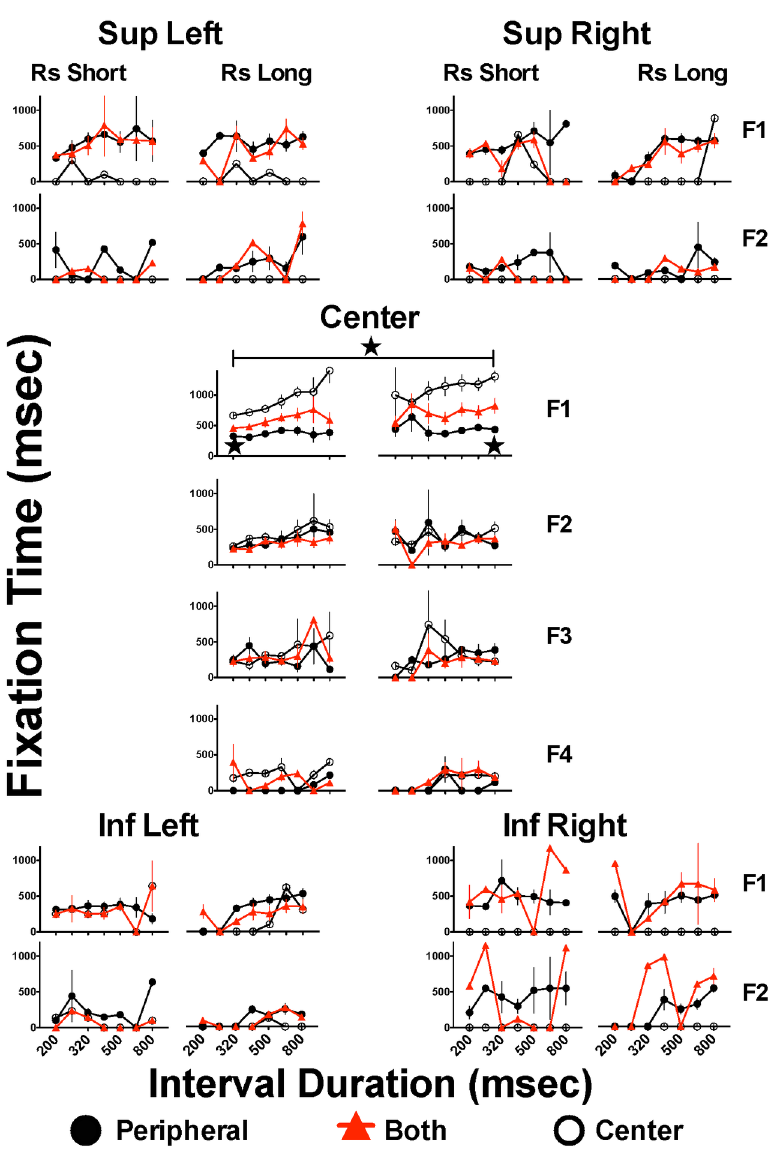
Fig 3. Duration of successive fixations on each Area of Interest during generalization trials. Mean fixation time in each successive fixation to each Area of Interest (AoI) where a stimulus could appear: fixation 1 (F1) to fixation 4 (F4) for Centre AoI but only F1 and F2 for remaining AoIs. For each fixation to each AoI, left panels present the performance on trials where subjects categorized intervals as “ short ” and right panels correspond to categorizations as “ long ” ; only intervals close to or at the extreme durations present mean of 15 subjects since some subjects never emitted erroneous categorizations. Stars and horizontal bars indicate significant differences between denoted groups after two-way ANOVA followed by Bonferroni´s test (p < 0.05) (see text); only data from anchor intervals with N = 15 were included in statistical